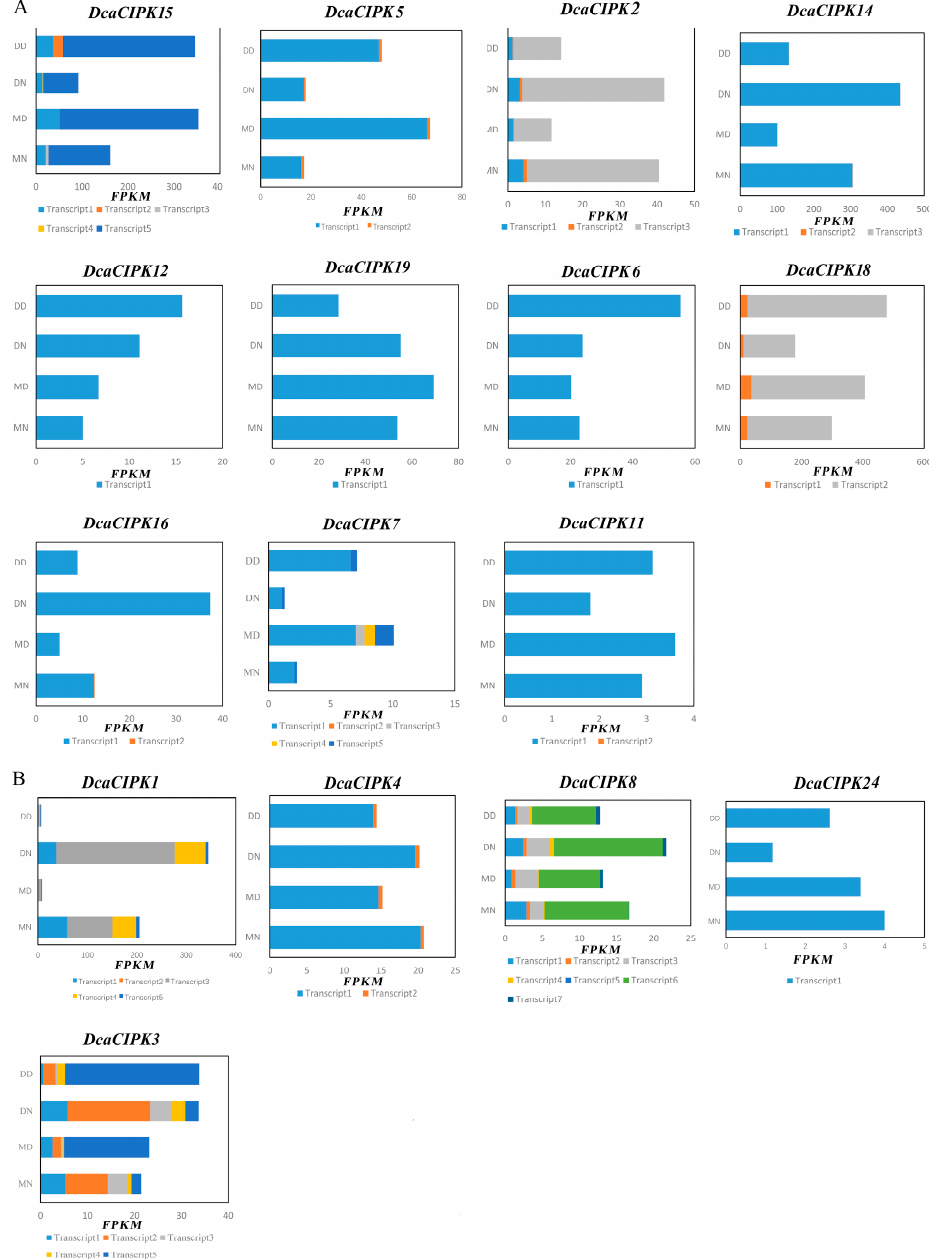
Figure 6. Abundance of DcaCIPK s’ alternative splicing isoforms under drought stress. ( A ) Intron-poor group. ( B ) Intron-rich group. DD represents drought treatment in daytime; DN represents drought treatment in nighttime; MD represents moist treatment in daytime; MN represents moist treatment in nighttime.